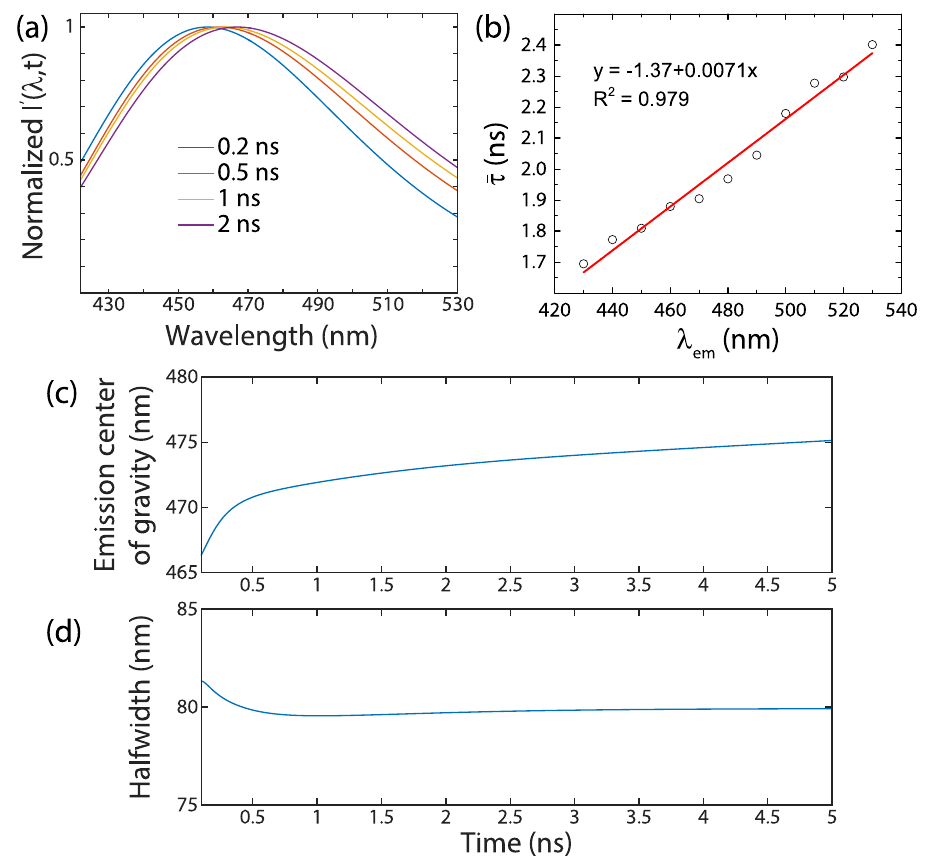
Figure 4. Results of TRES and lifetime analysis. ( a ) TRES spectra taken at different instances of time after the excitation, ( b ) Average lifetime as the function of emission spectrum wavelength, ( c ) Emission center of gravity as a function of time after excitation and ( c ) the fluorescence emission halfwidth as the function of time after